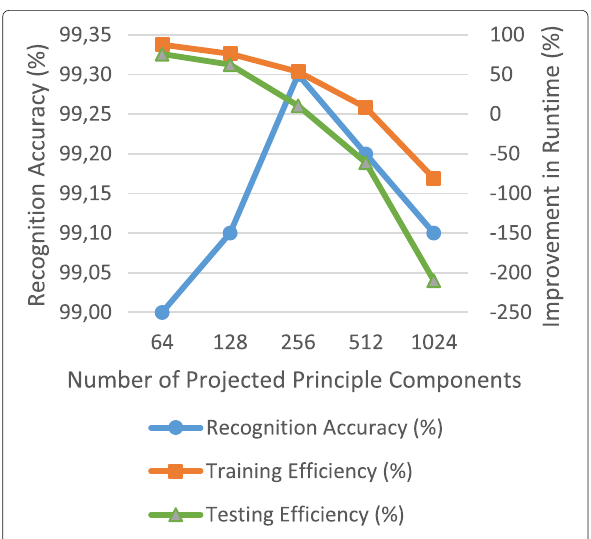
Fig. 11 The effect of varying the number of projected principle components on recognition accuracy and runtime for six classes of emotion in the CK+